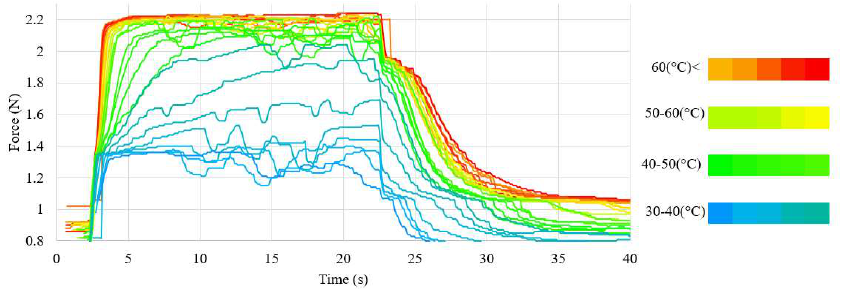
Figure 8. Waveform of the displacement in relation to the average temperature during heating (test sample diameter, 150 μm).